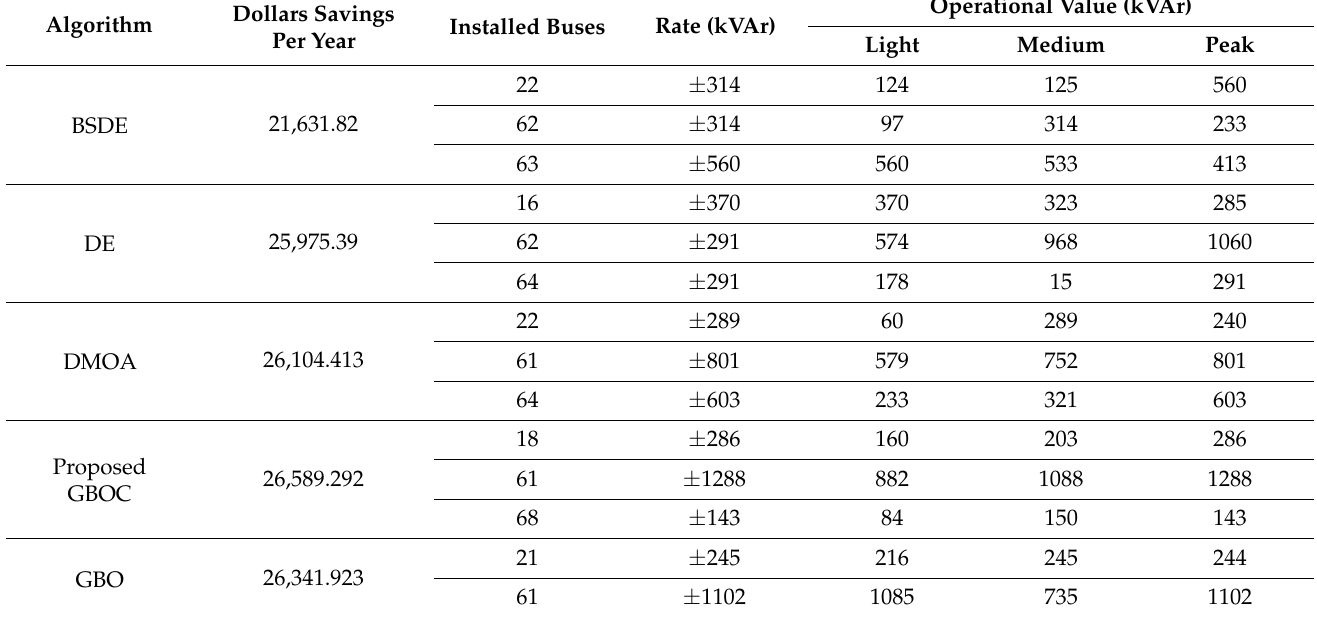
Table 6. Placement and sizing of D-SVC devices for the IEEE 69-distribution system for Scenario